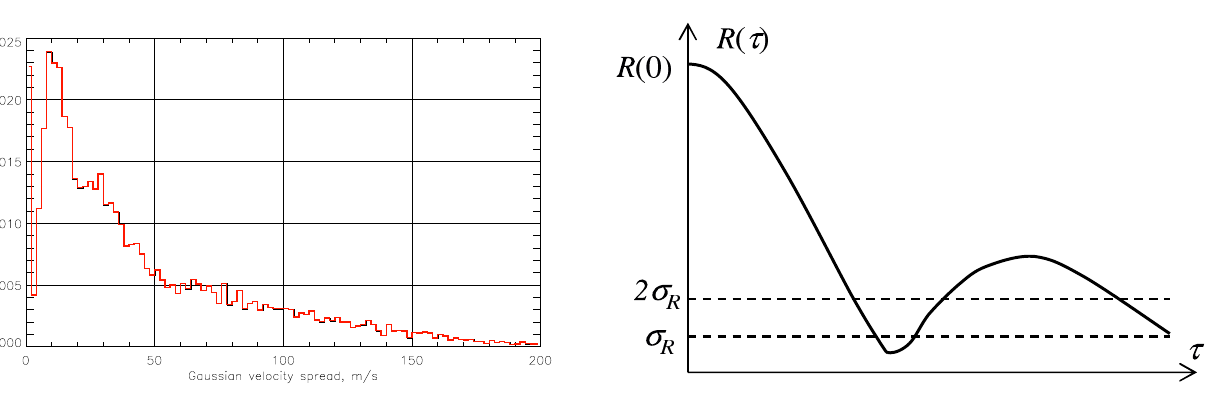
Fig. 18. Histogram of random velocity variations shown in Fig. 17. Fig. 19. Illustration of the criterion used for identifying multi- component